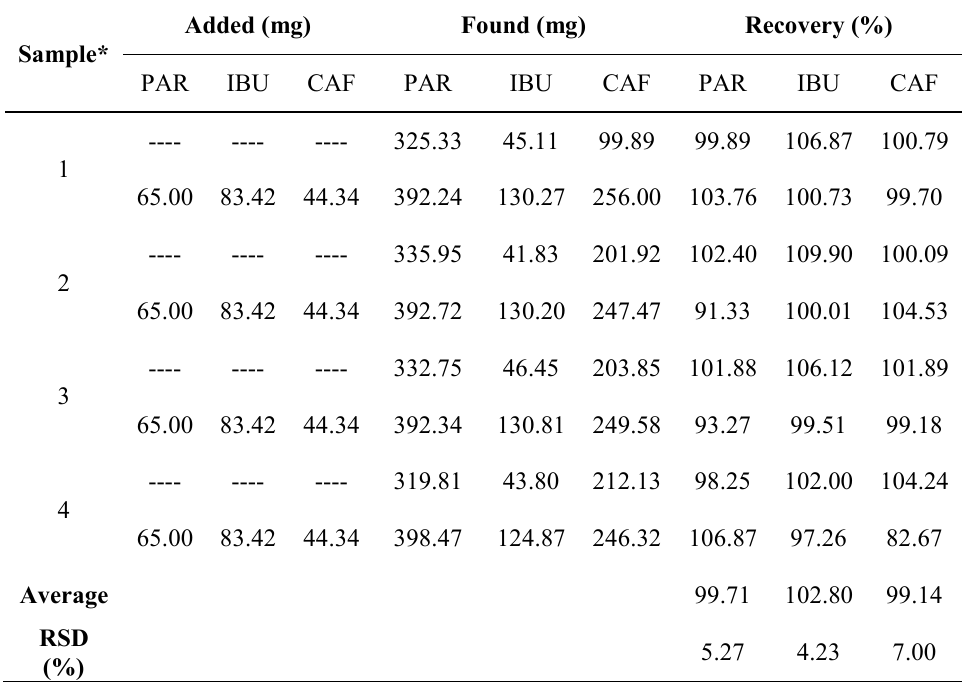
Table 3. Determination of paracetamol, ibuprofen and caffeine in some ternary pharmaceutical